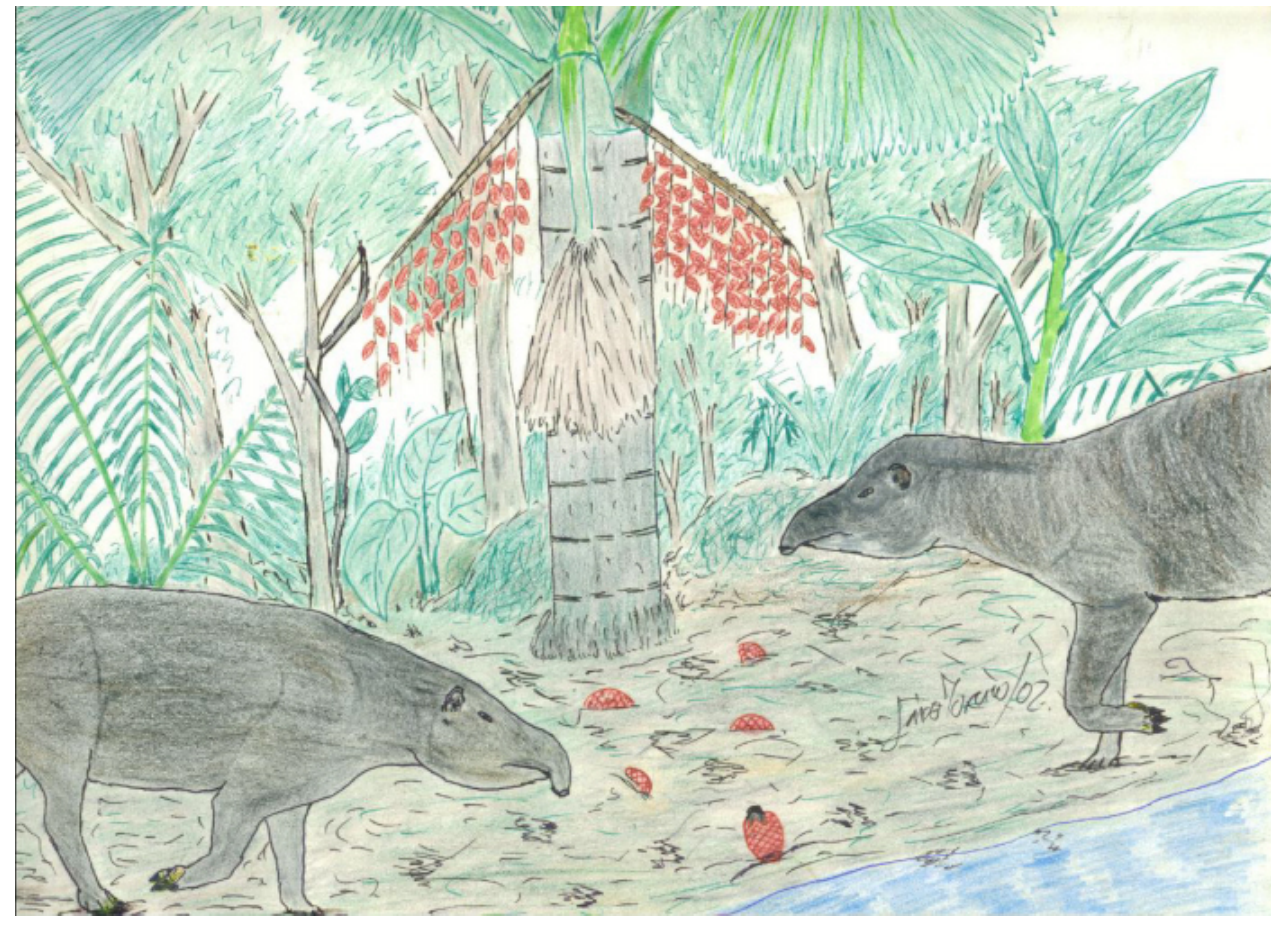
Fig. 3. Drawing of a Canangucho fruiting palm ( Mauritia flexuosa ) done by Jairo Moreno. According to indigenous people, drawings may include large amounts of information. For instance, in this case it indicates a particular place/forest type. This palm is generally found in patches locally known as Cananguchales, which are backswamps with poorly drained soils, and time of the year, i.e., June–July, canangucho fruiting season. Also, information on seed dispersal is provided: fruits consumed by "Danta de pintura negra," the Black Painted Tapir ( Tapirus terrestris ), as well as mythological associations. The cananguchales are sacred sites where animals meet on a particular time of the